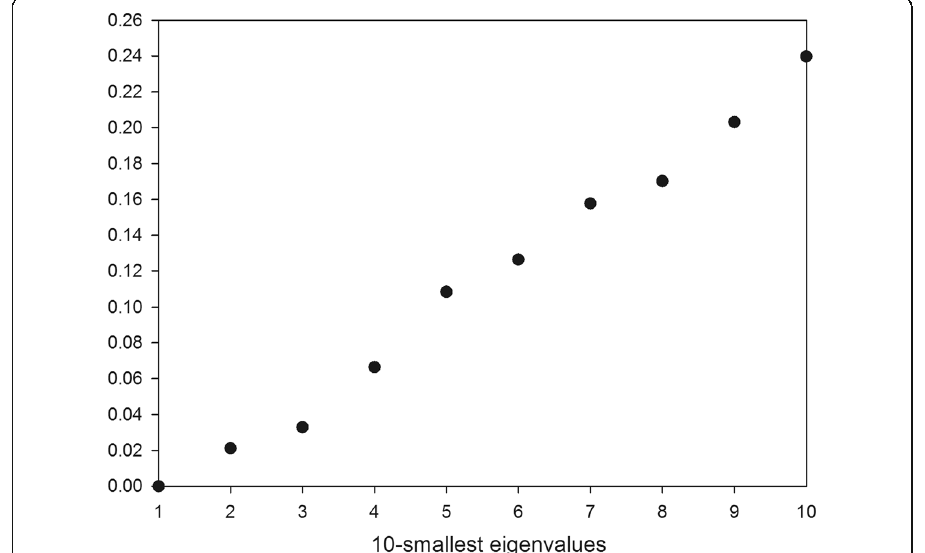
Fig. 1 First 10 -smallest eigenvalues of unweighted graph Laplacian